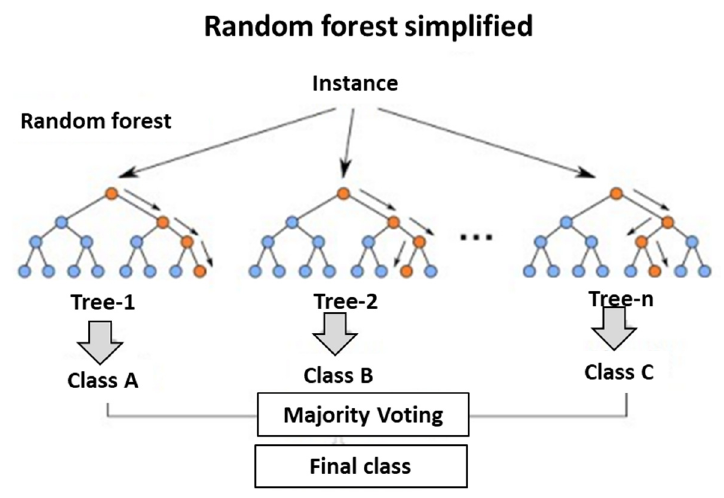
Figure 7. Random forest classifier algorithm graphically demonstrated. Taken from references [56,57].